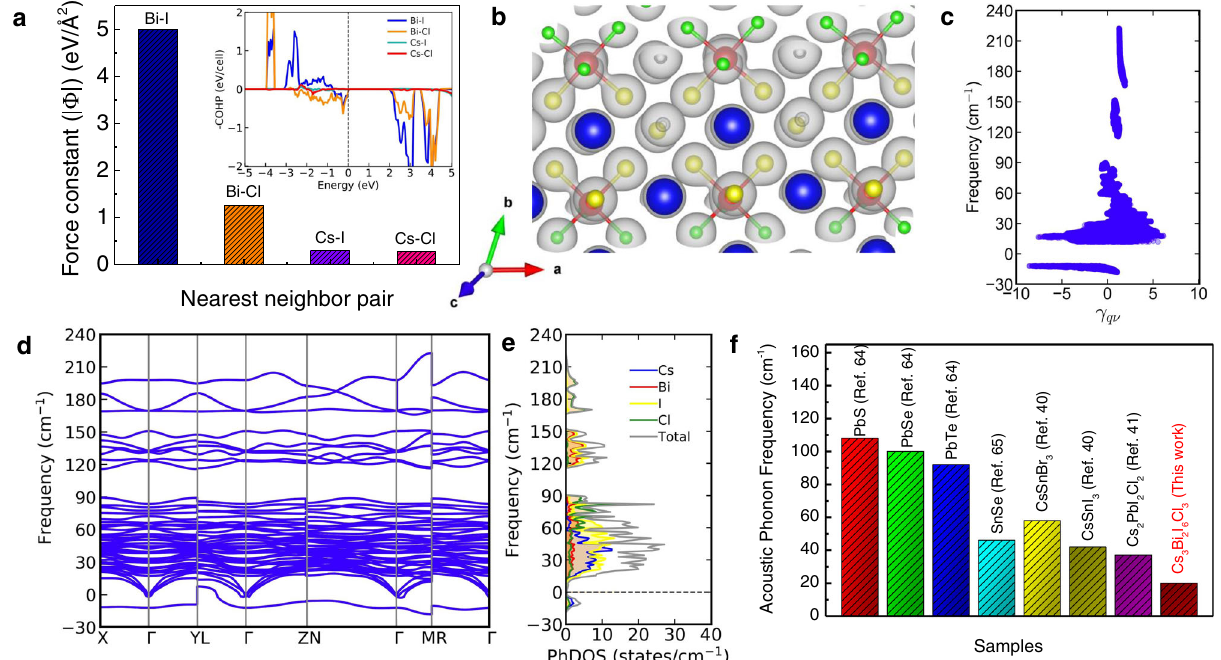
Fig. 3 | Chemical bonding and lattice dynamics of Cs 3 Bi 2 I 6 Cl 3 . a Harmonic interatomicforceconstantsforthenearestneighboratompairsinCs 3 Bi 2 I 6 Cl 3 .Inset shows the crystal orbital Hamilton population (COHP) analysis of Cs 3 Bi 2 I 6 Cl 3 . Positive and negative valuesinthe y -axisindicatebondingand anti-bondingstates, respectively. b Total charge-density plot in the supercell of Cs 3 Bi 2 I 6 Cl 3 , where iso- surfaces of charge-density are shown in light gray color. Isosurface of charge